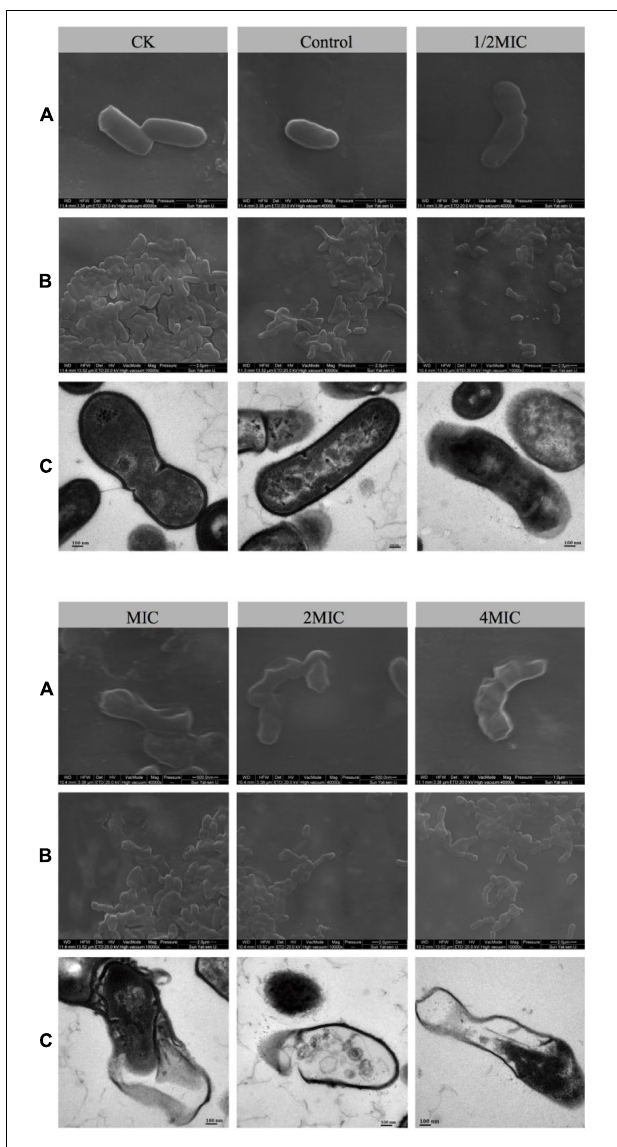
FIGURE 2 | The effects of EO on the morphology of C. acnes cells were observed by scanning electron microscope (SEM) and transmission electron microscope (TEM), followed by normal bacteria (CK), solvent control bacteria (Control), and bacteria treated with different concentrations of EO (1/2 MIC, MIC, 2 MIC, and 4 MIC). (A) SEM image of C. acnes at 40,000 × magnification. (B) SEM image of C. acnes at 10,000 × magnification. (C) TEM image of C. acnes at 50,000 ×